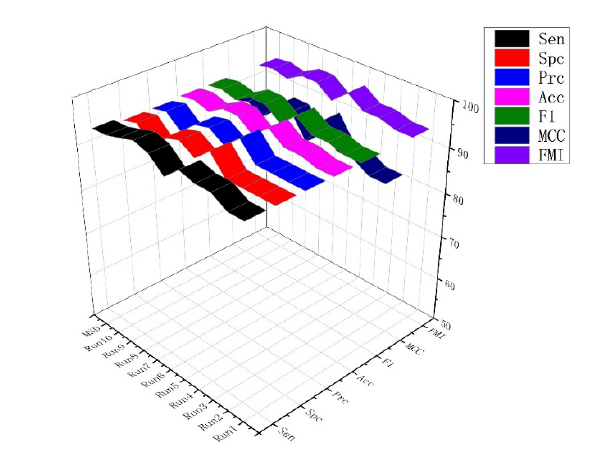
Fig. 12 Performance results of